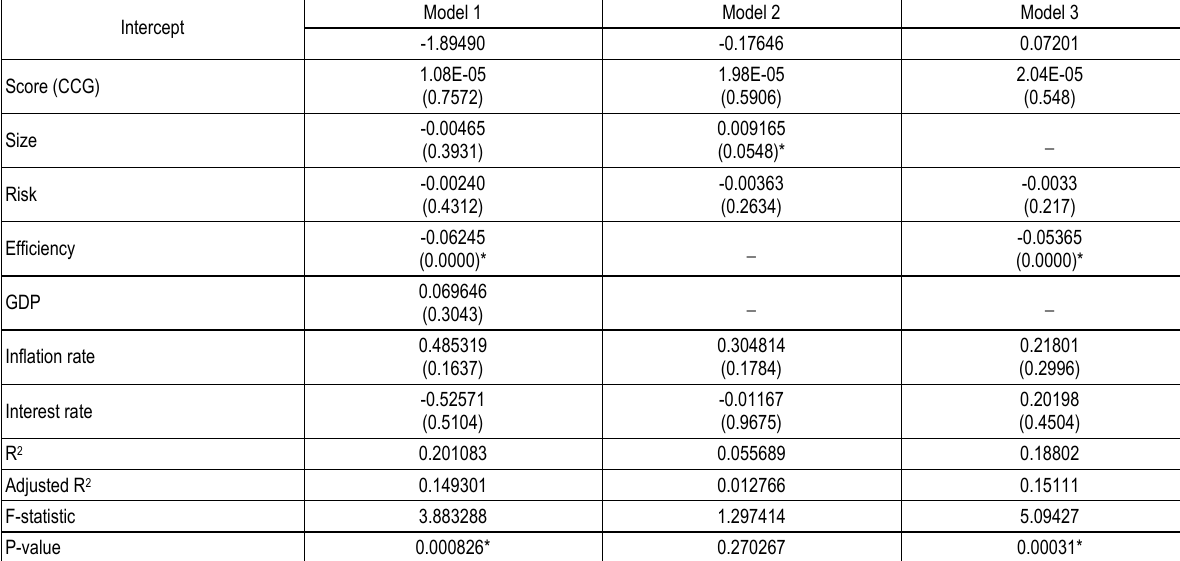
Table 3. Regression а